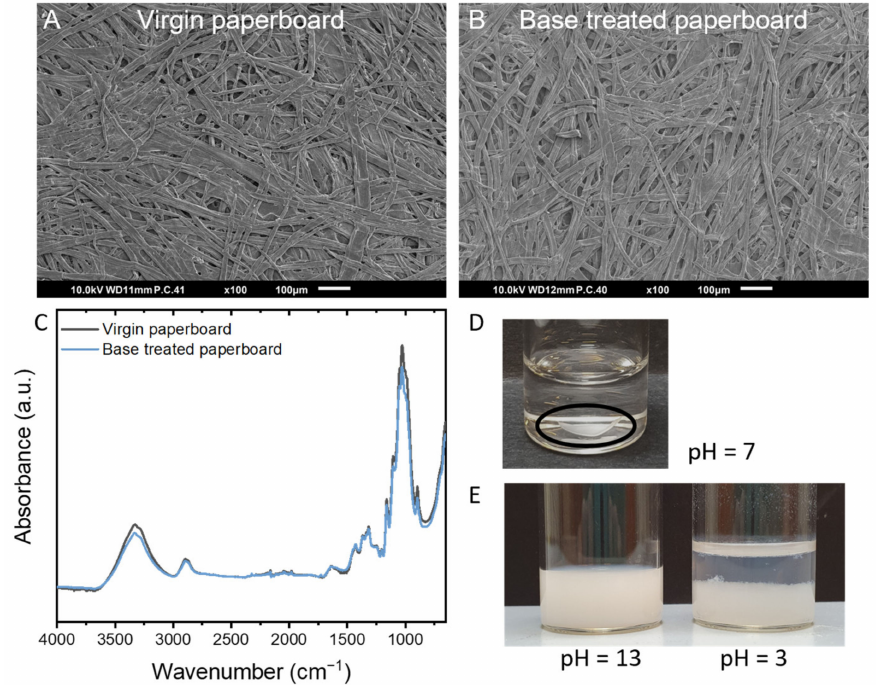
Figure 5. SEM images of the ( A ) virgin and ( B ) base-treated (0.1 M NaOH (aq) for 5 min) uncoated paperboard with ( C ) corresponding FTIR spectra. ( D ) Photograph of free-standing film (in black circle) immersed in demineralized water (pH = 7). ( E ) Photograph of free-standing film of the coating dispersed in pH = 13, followed by lowering the pH to 3 causing sedimentation of the